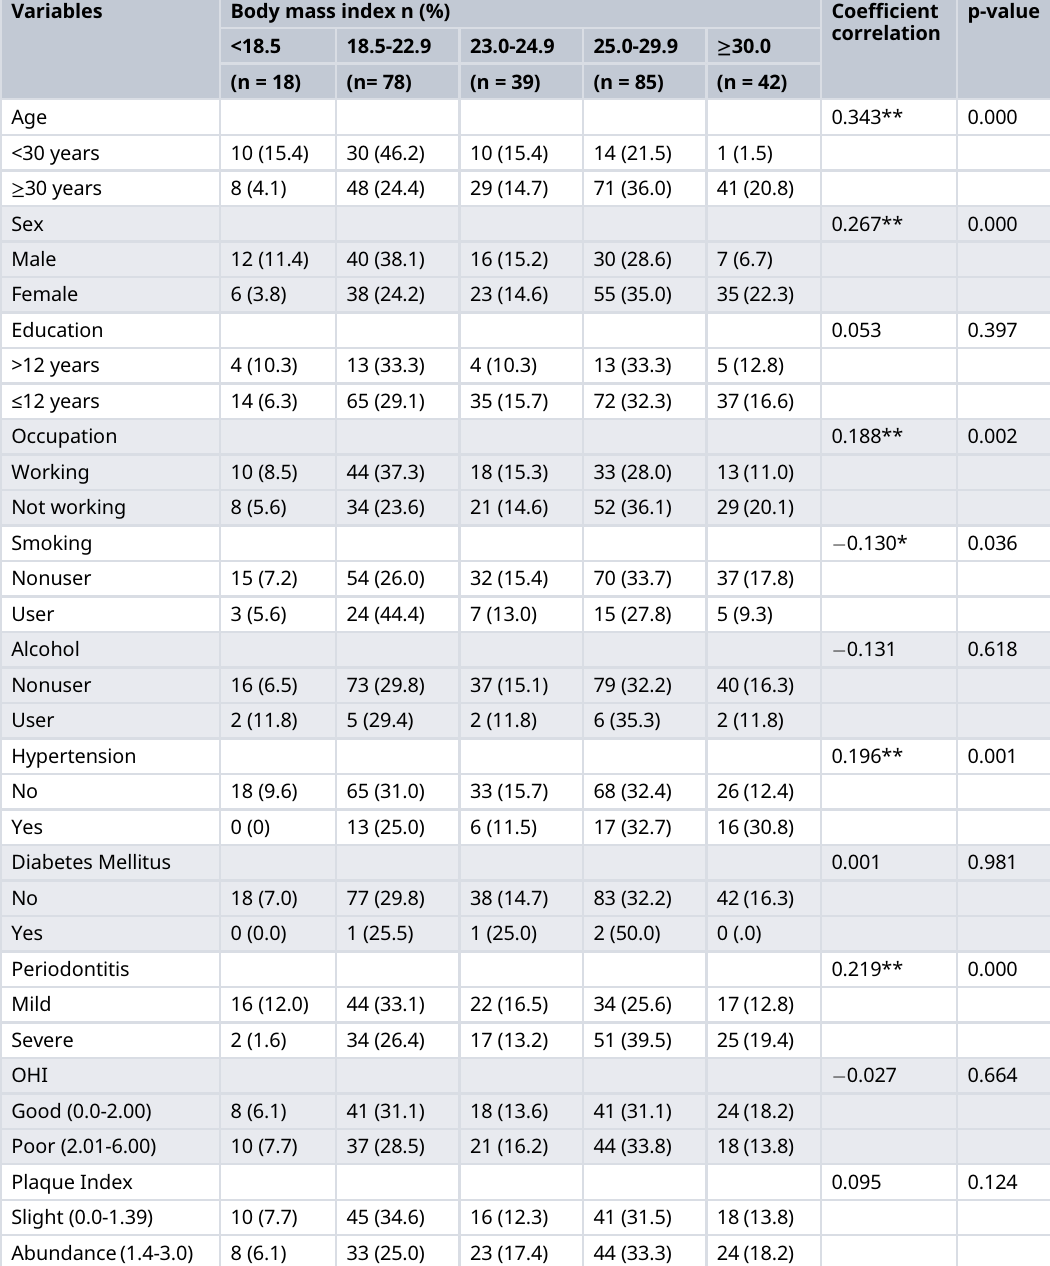
Table 2. Correlation between socio-demographic data, DM, hypertension, oral hygiene and body mass